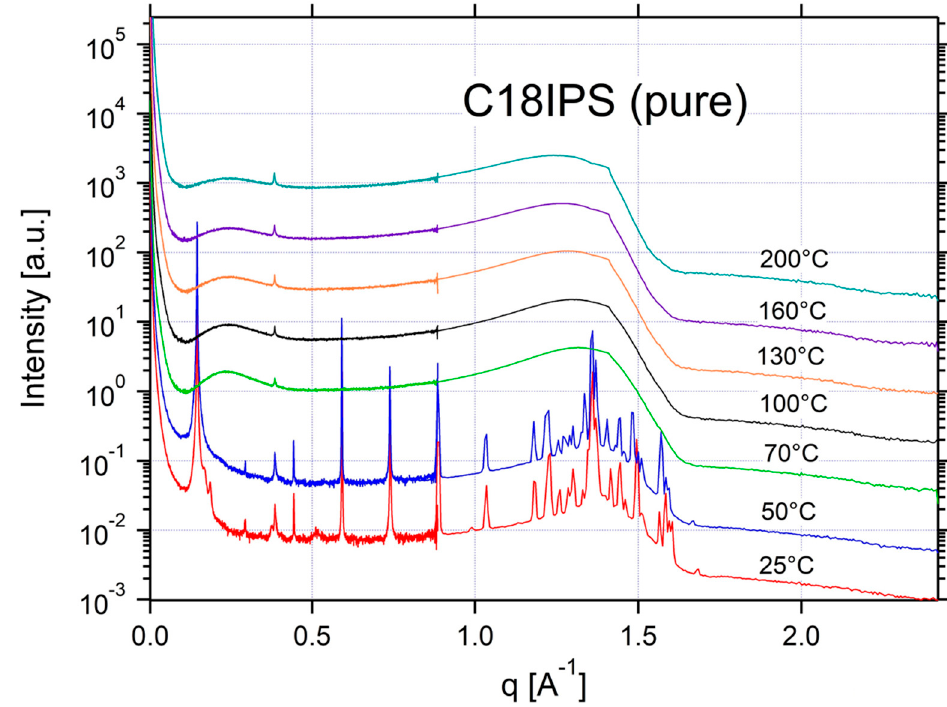
Figure A21. SAXS and WAXS data for pure C18IPS.